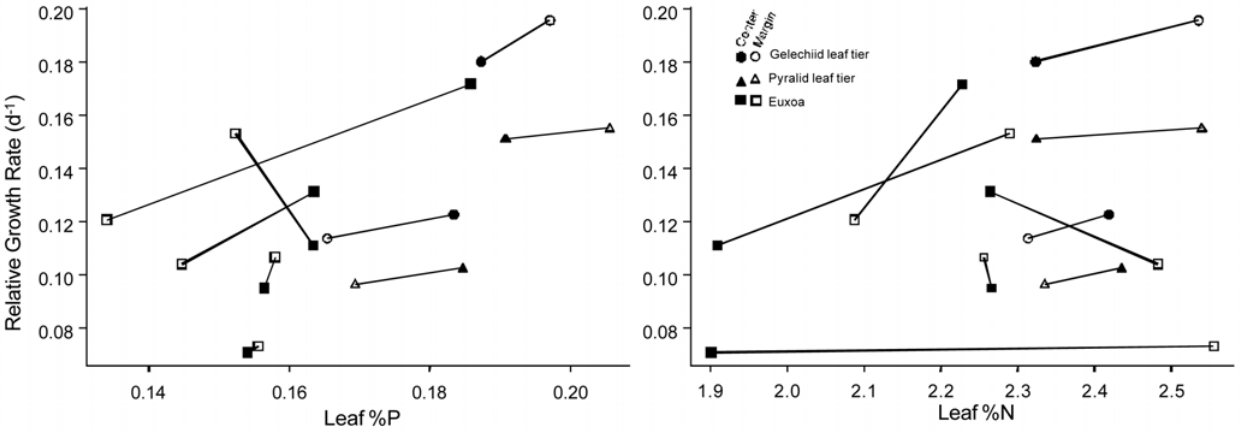
Figure 1. RGR is related to %P in wild-collected leaves. RGR (d 2 1 ) is closely related to leaf % P (a) but not leaf %N (b). Each point represents the mean of 15–86 individual larvae fed a particular batch of food. Groups of larvae feeding on different diets during the same time interval are connected by lines. Filled symbols represent feeding on leaves from high-density center areas.